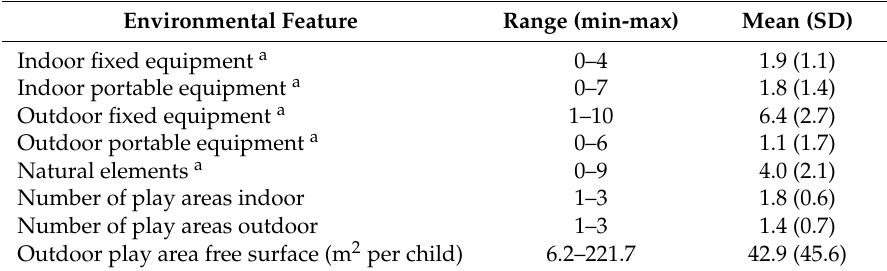
Table 2. Descriptive statistics of physical environmental